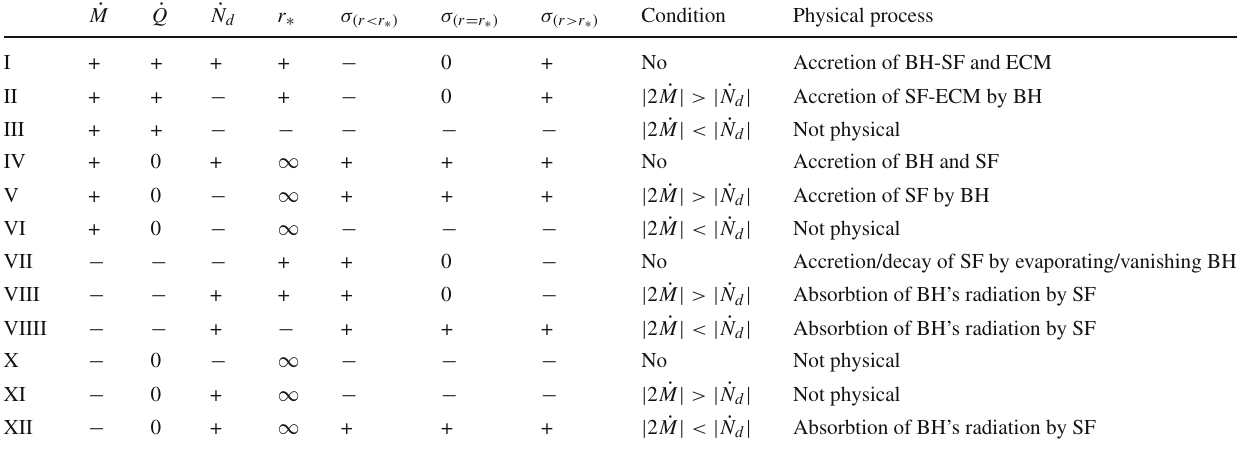
Table 2 General Bonnor–Vaidya BH and its dust SF parameters for (cid:2) = +